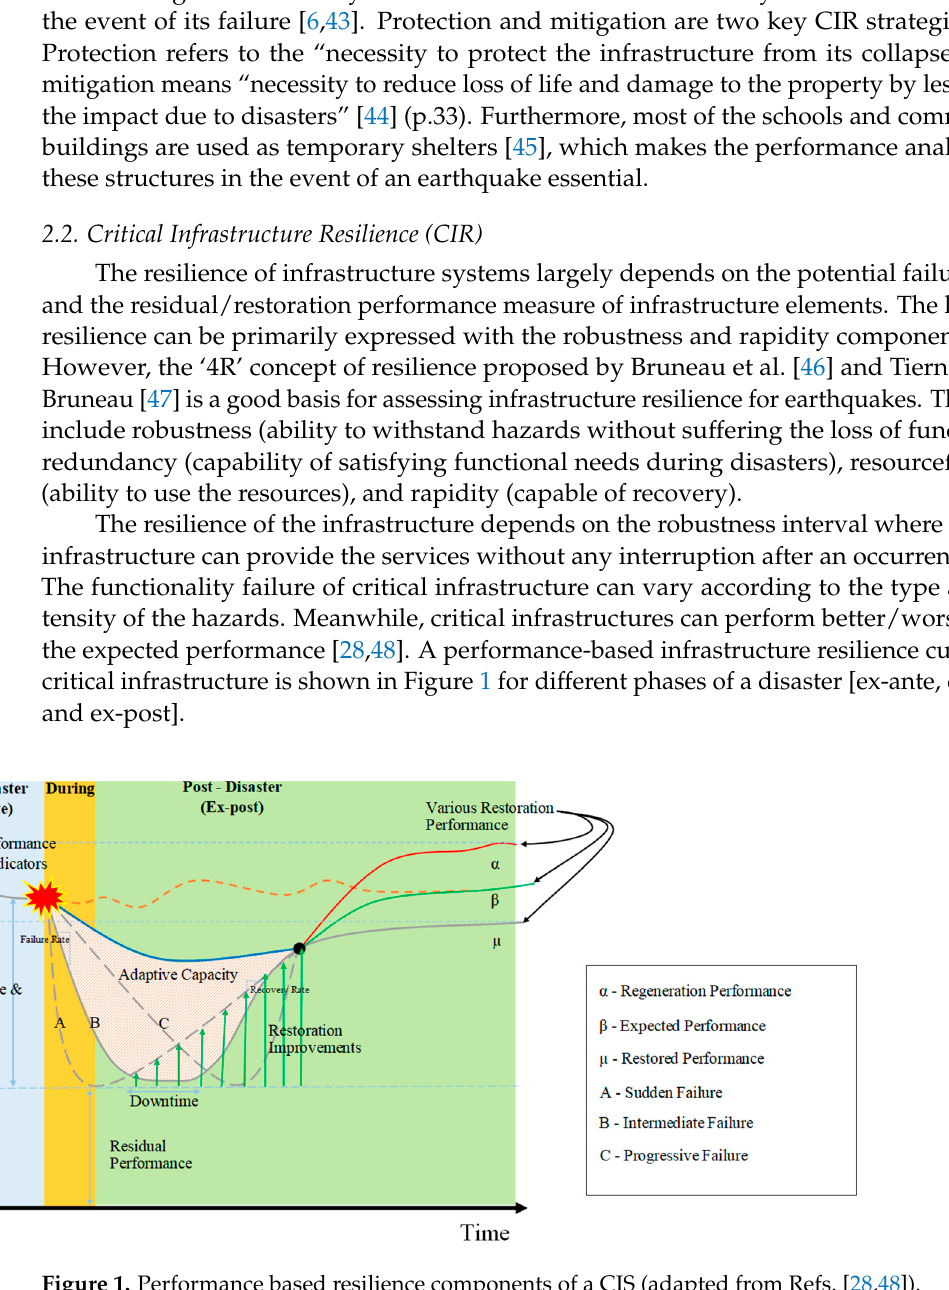
Figure 1. Performance based resilience components of a CIS (adapted from Refs. [28,48]). The performance of infrastructure can be dropped to a level lower than the targeted level or the preperformance level ( β line) immediately after a disaster. The failure can occur in terms of functionality and serviceability as a sudden or progressive failure depends on the disaster intensity and the resilience to that disaster event (A, B, and C). The restoration performance of the infrastructure can be expected at different levels such as restored performance ( α ), expected performance ( β ), and regeneration performance ( µ -higher performance than expected). The resilience of a critical infrastructure can be assessed with the key performance indicators such as functionality and serviceability.